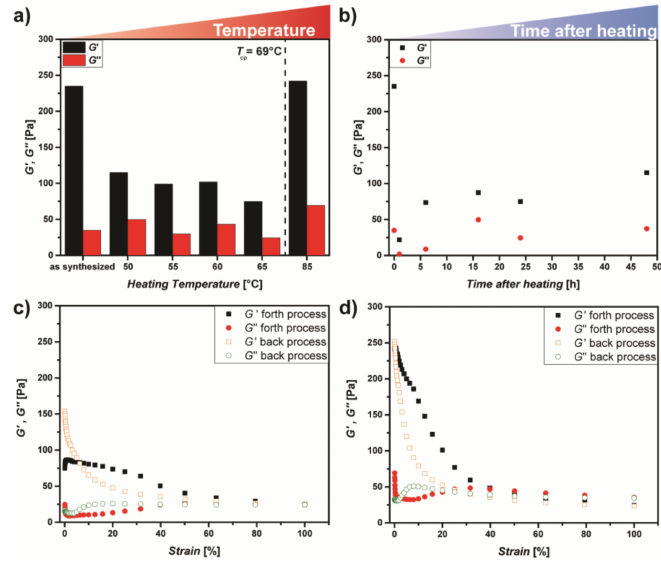
Figure 3. Rheological characterization of PVP 41k - b -POEGMA 22k (3.3 wt.%)/ α -CD (10.4 wt.%) hydrogel: ( a ) after heating to various temperatures, subsequent cooling to 25 ◦ C and standing for 24 h; ( b ) after heating to 65 ◦ C, subsequent cooling to 25 ◦ C and standing for indicated times; ( c ) strain dependency after heating to 65 ◦ C and cooling to 25 ◦ C; ( d ) strain dependency after heating to 85 ◦ C and cooling to 25 ◦